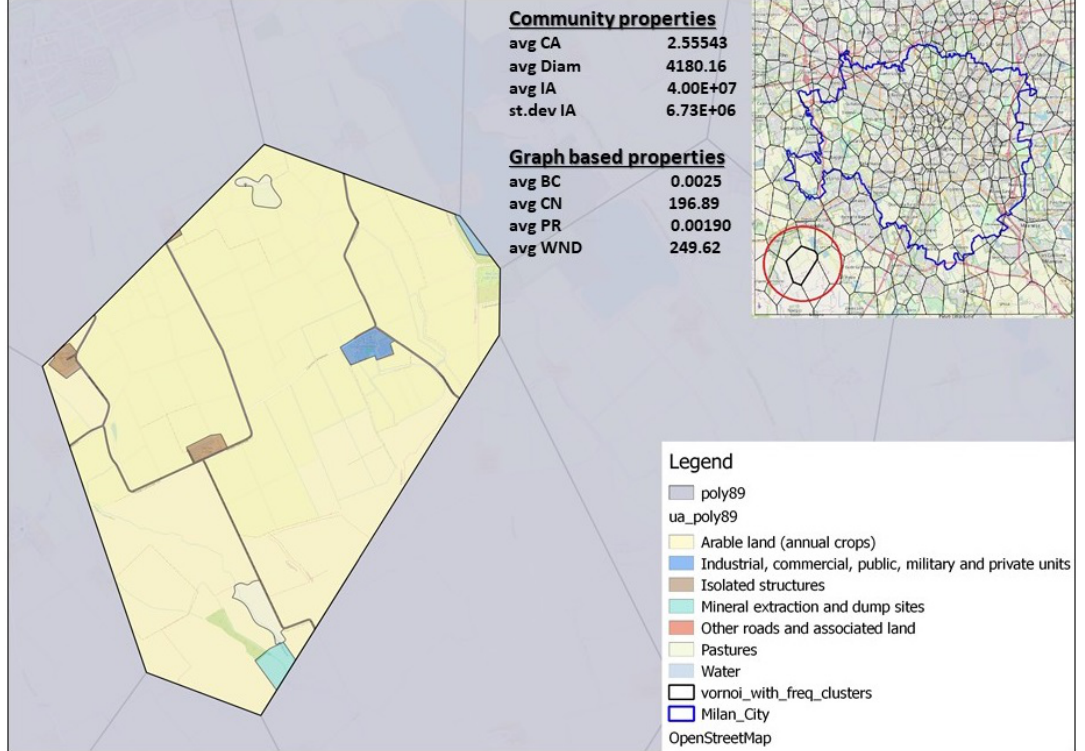
Figure 12. Land use profile of polygon where the dominant class is Arable land